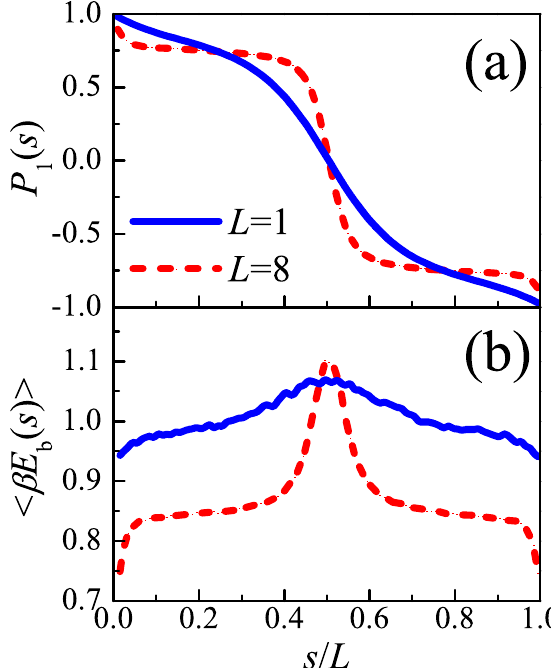
Figure 5. ( a ) The segment orientation functions and ( b ) the bending energy versus the coordinate along the loop chain. The blue solid lines and red dash lines represent the tight fold ( L = 1) and loose loop ( L = 8), respectively. s is scaled by loop length L